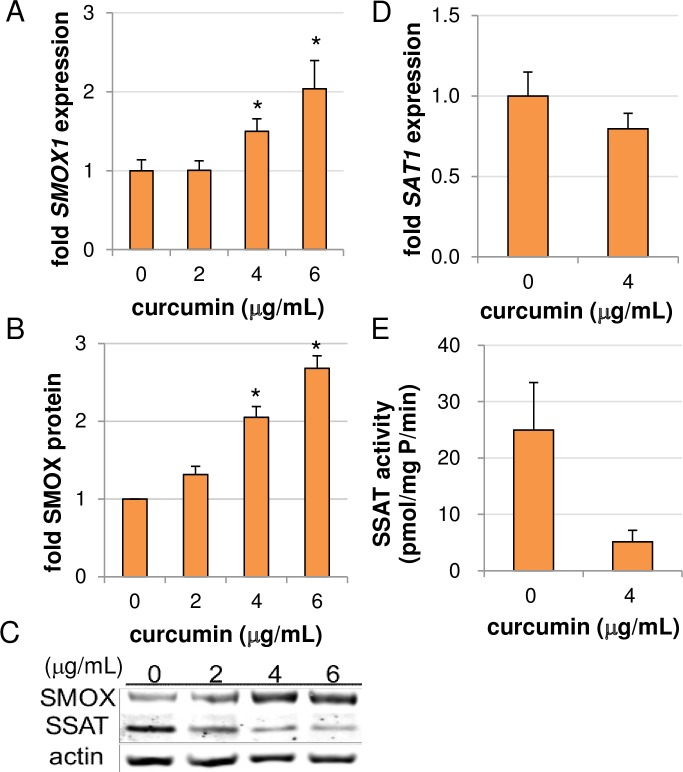
Curcumin induces spermine catabolism through spermine oxidation in AGS cells.AGS cells were treated for 48 hours and analyzed for SMOX (A) and SSAT (D) mRNA expression via qRT-PCR; (B-C) SMOX and SSAT protein levels by Western blot; and (E) SSAT enzyme activity. Graphs depict the mean values of at least 2 individual experiments, each measured in triplicate. Error bars = SEM; *p < 0.05. A representative western blot is presented in (C).